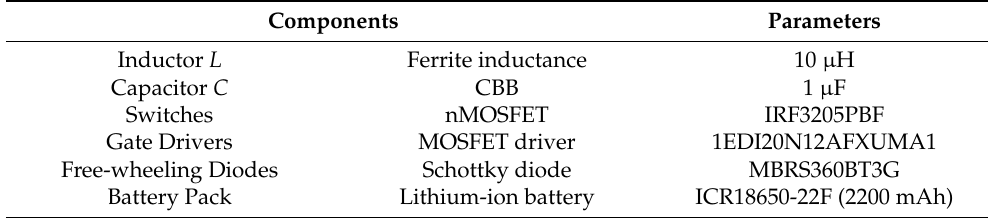
Table 4. The parameters of the prototype.